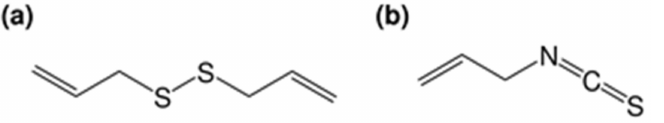
Figure 2. Chemical structures of ( a ) diallyl disulfide and ( b ) allyl